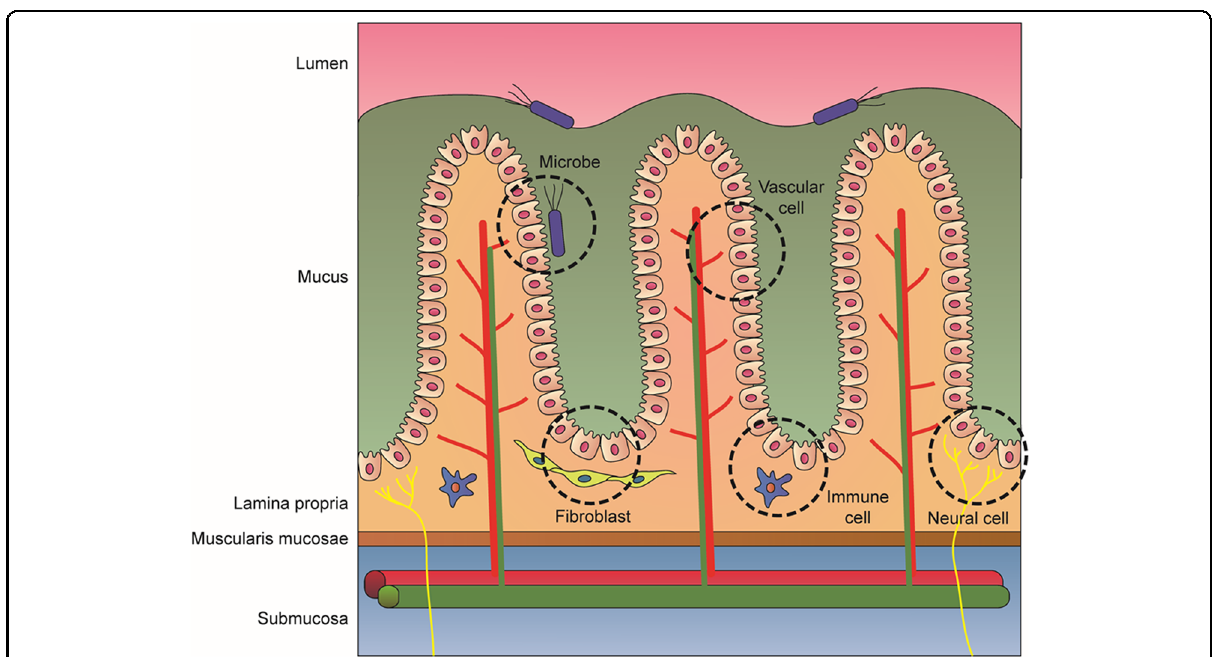
Fig. 1 Image of GI epithelium and the surrounding tissues. In GI tissues, there are numerous interactions between the epithelium and microbes or other cells, such as fi broblasts, vascular cells, immune cells and neural cells. Their communication has signi fi cant effects on the functions and homeostasis of the epithelium, indicating the necessity of including stromal cells and microbiota for producing functional 3D organoid models of the GI